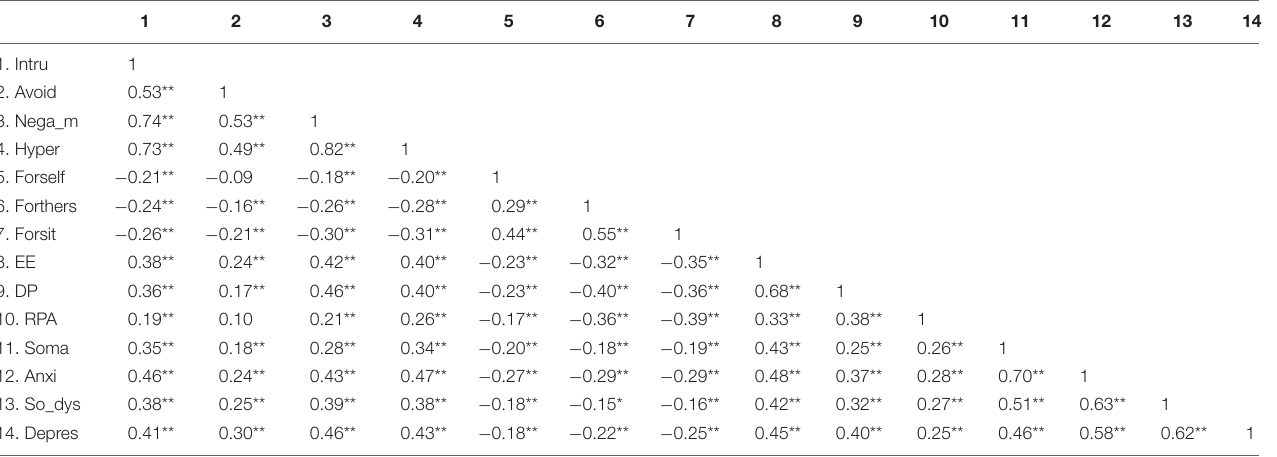
TABLE 2 | Correlation matrix among subscales of PTSD, forgiveness, burnout, and psychiatric co-morbidity. 1 2